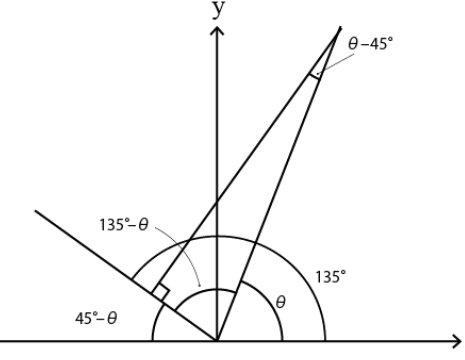
Figure 4. Projected gradient of 135 ◦ .